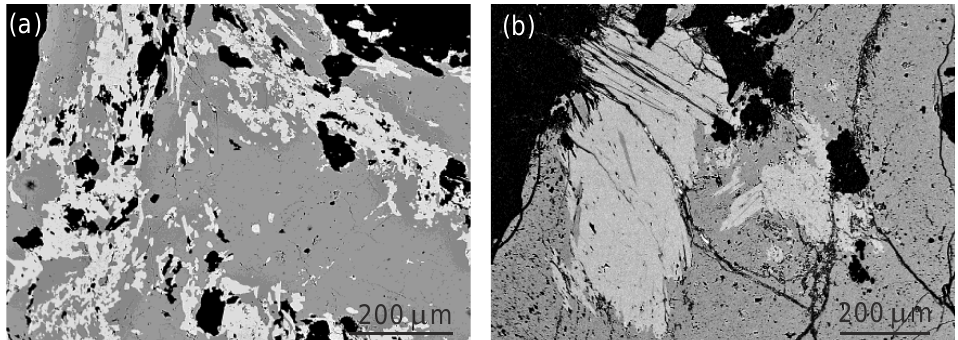
Figure 2. ( a ) Abundant, irregularly dispersed round to elongated inclusions of zinkenite (white) in stibnite (grey); ( b ) scainiite aggregates (light grey) in earlier aggregates of zinkenite (dark grey). BSE photos.